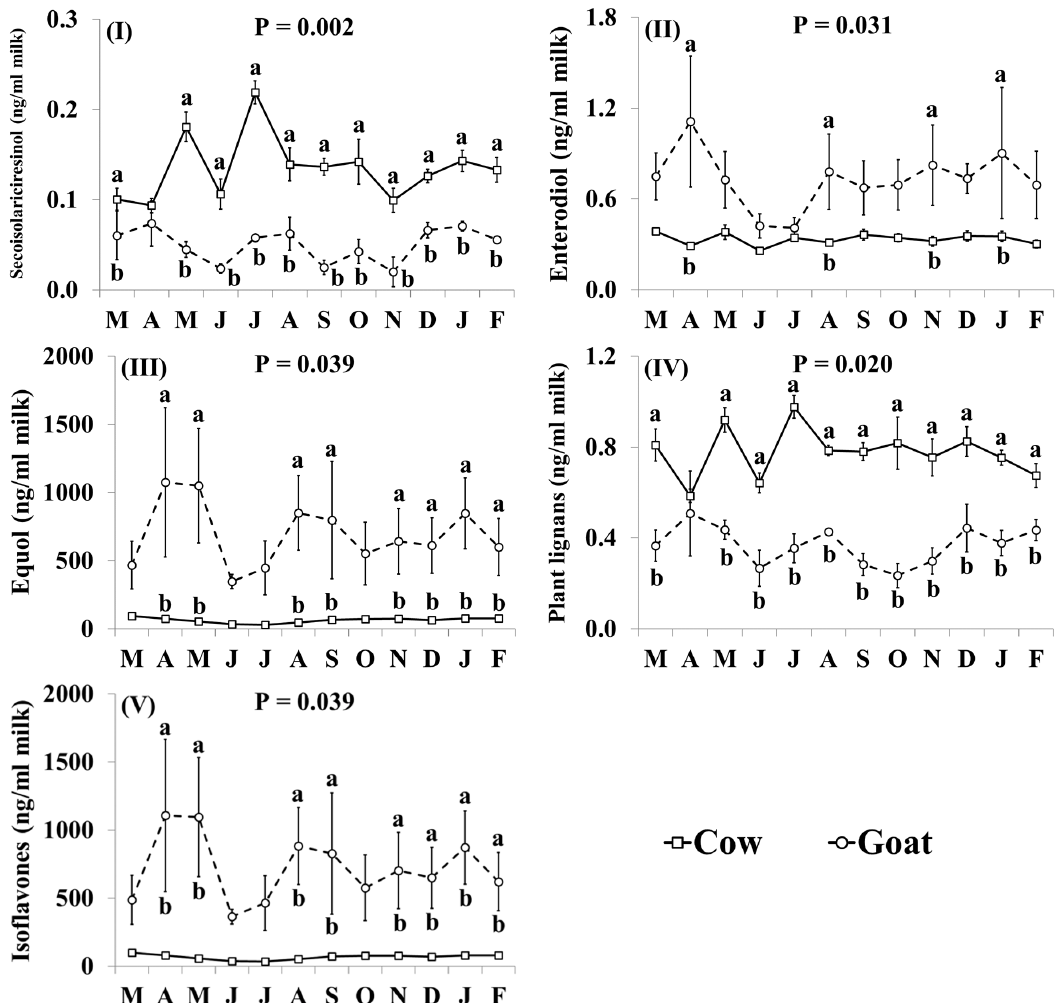
Figure 5. Interaction means ± SE (error bars) for the effects of species (cow, goat) and month (in order of appearance from left to right in Axis X: M, March; A, April; M, May; J, June; J, July; A, August; S, September; O, October; N, November; D, December; J, January; F, February) on phytoestrogen concentrations of retail milk: (I) secosisolariciresinol, (II) enterodiol, (III) equol, (IV) total plant lignans, (V) total isoflavones. P represents the ANOVA p -value for the interaction. Means for species and within a month with di ff erent lowercase letters are significantly di ff erent according to Fisher’s Least Significant Di ff erence test ( p <